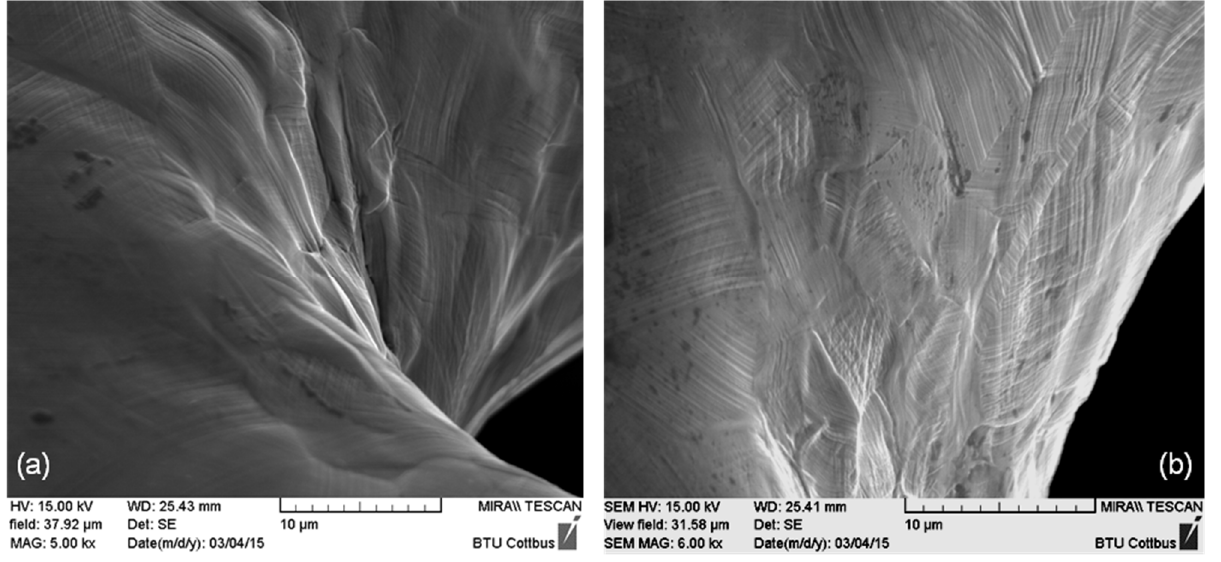
Figure 2. ( a ) Inner part of a stent bow and ( b ) passage between bow and strut of a